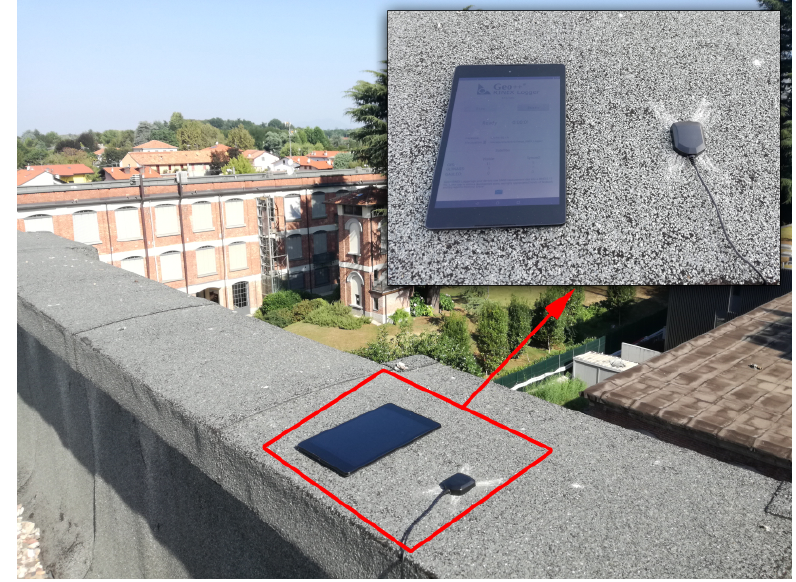
Figure 1. Nexus 9 tablet ( left ) and u-blox ANN-MS antenna ( right ) at the experiment